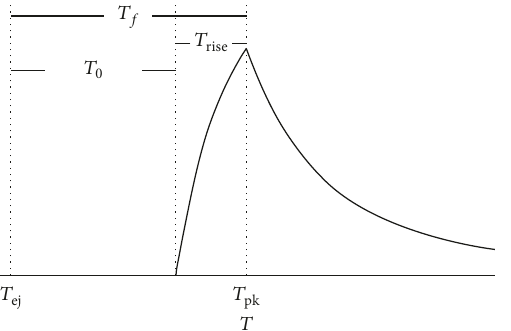
and 𝑇 (denoted by ej peak . (Figure after rise